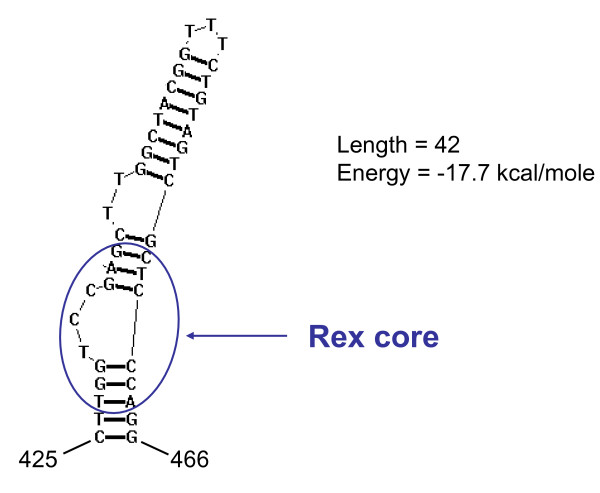
Plot of predicted RNA stem loop secondary structure of HTLV-4(1863LE) LTR region. Position of the Rex responsive element (RexRE) core is indicated.